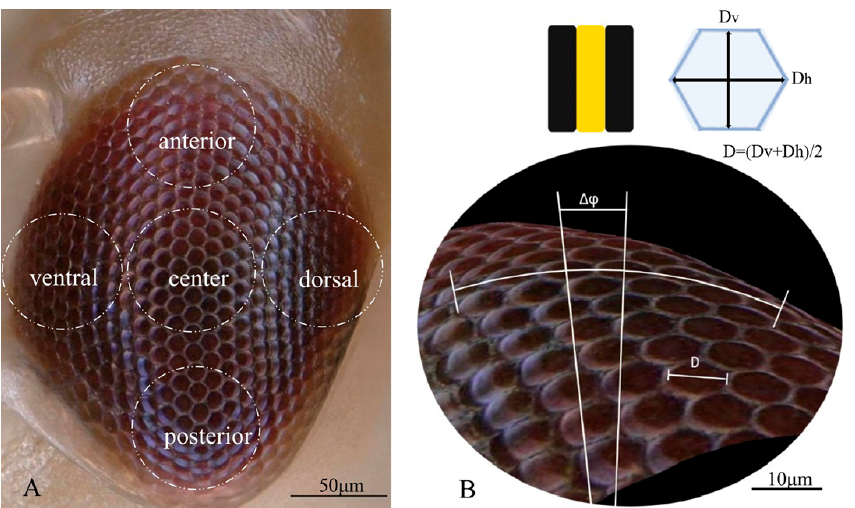
Figure 1. Interommatidial angle ( Δ ϕ ) and ommatidia diameter ( D ) measurements of the compound eye. ( A ) The compound eye is divided into five regions: posterior, ventral, central, anterior, and dorsal. ( B ) Side view of the adjacent ommatidia interommatidial angle and diameter. The hexagonal ommatidia with six adjacent ommatidia were used to measure the radius of curvature, and the corresponding angle ( ∆ φ ) was calculated between two ommatidia. The diameter of a single ommatidium was the mean distance between the longest diagonal ( D h) and the shortest edge ( D v) of the hexagonal ommatidium. The ommatidia diameter ( D ) was the mean of eight ommatidia in each region. The Interommatidial angle and the ommatidium diameter were measured using the manufacturer’s software. Each hexagonal ommatidium was divided in three axial directions according to the midline of the opposite side, and the angle corresponding to the radius of curvature between the center points of several adjacent ommatidia was calculated from the side view. The angle was divided by the number of ommatidia (Figure 1B), and the mean value of the three axial angles was regarded as the mean interommatidial angle ( ∆ φ ) [16]. The diameter of a single ommatidium was the mean distance between the longest diagonal ( D h) and the shortest edge ( D v) of the hexagonal ommatidium. Eight ommatidia were selected and measured to calculate the mean diameter ( D ) for each region. An independent-samples t -test was used to analyze the differences of ∆ φ and D between females and males. After confirmation that there was no difference in ∆ φ and D between the sexes, we pooled the data from both sexes and analyzed the differences in ∆ φ and D among the five regions in compound eyes using one-way ANOVA and LSD comparison (SPSS 14.0, Inc., Chicago, IL,